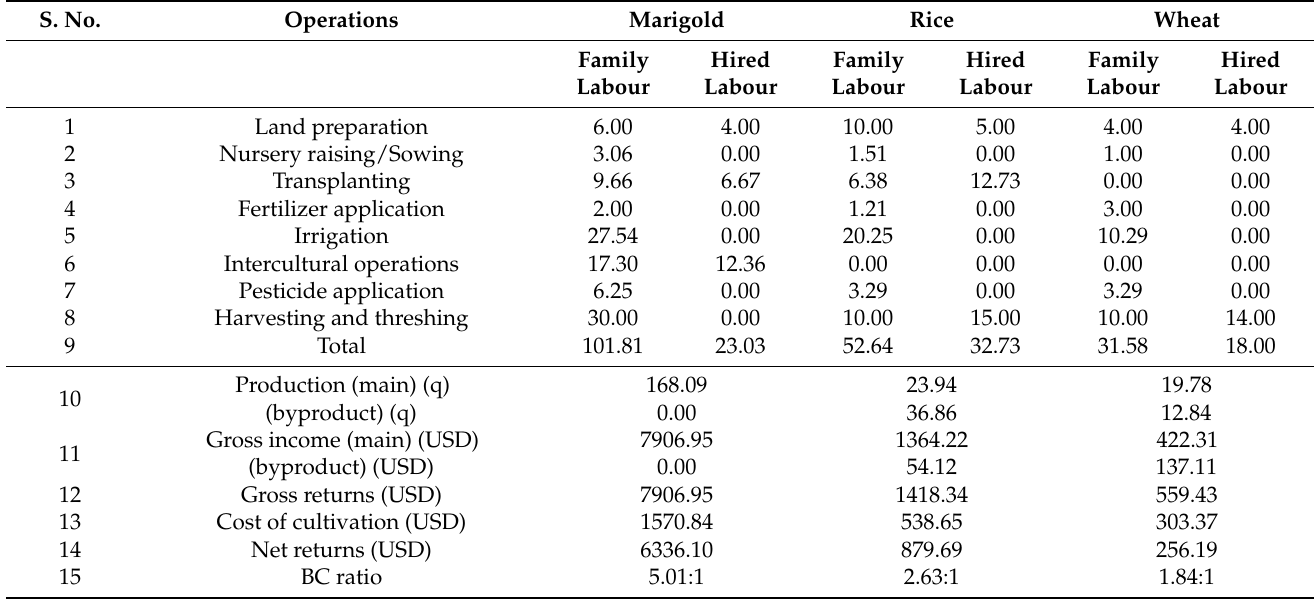
Table 5. Comparison of employment generation and benefits between marigold and cereal crops. S. No.